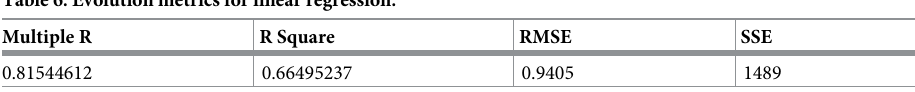
Table 6. Evolution metrics for linear regression.